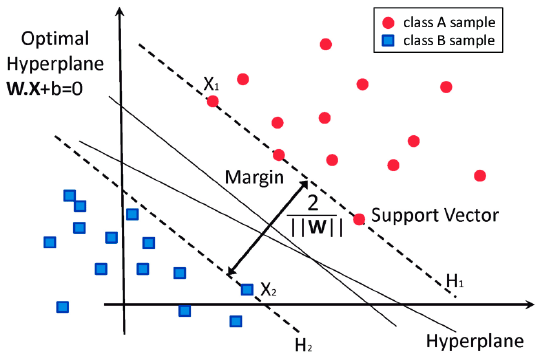
Figure 3 . Support vector machine